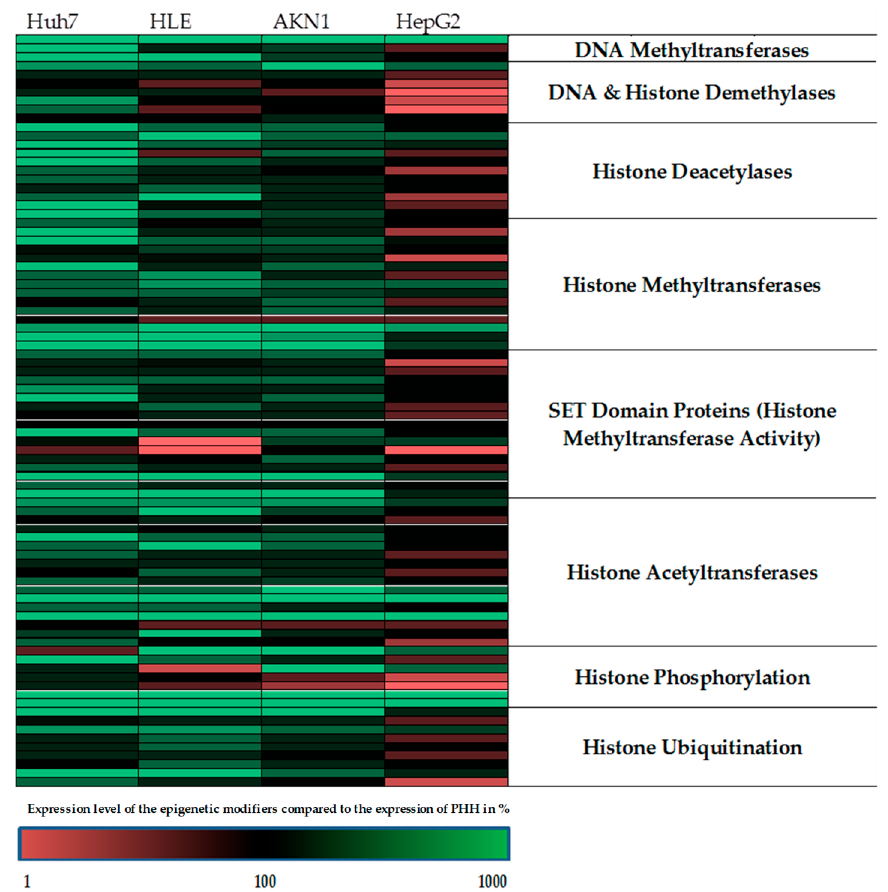
Figure 1. Summary of Human Epigenetic Chromatin Modification Enzymes PCR Array. The expression of 84 chromatin modification genes of four different hepatic cell lines in comparison with fresh isolated primary human hepatocytes (PHH) was shown as a heat map. The green color shows an upregulation of epigenetic modifier genes compared to PHH whereas the red color shows a downregulation of the corresponding genes compared to PHH.